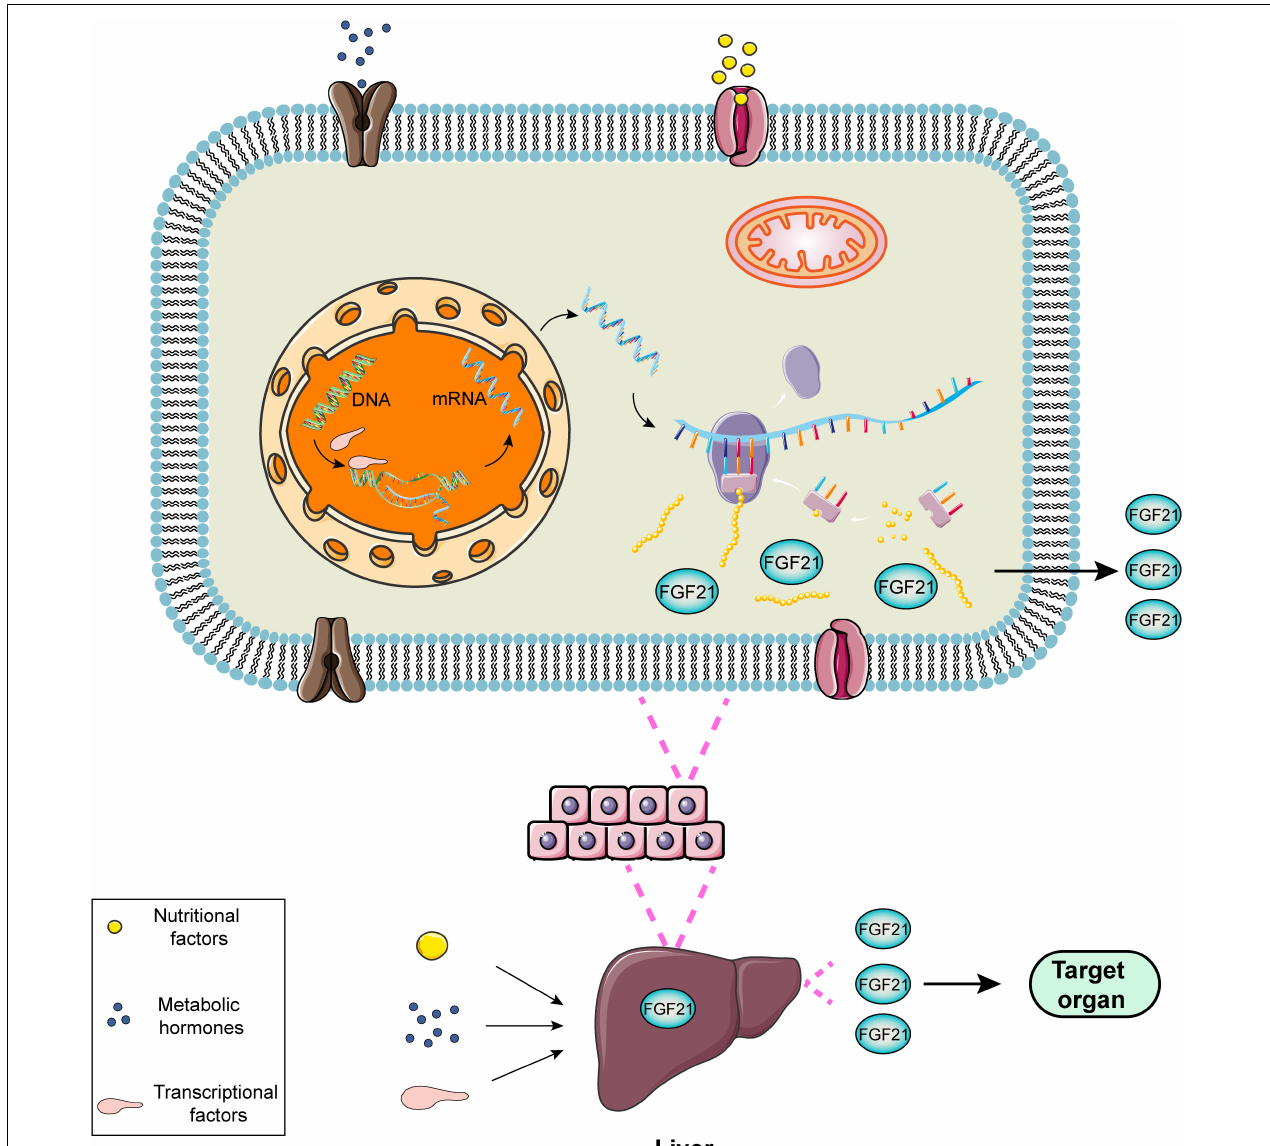
FIGURE 1 | Schematic diagram of the regulatory process of FGF21 expression. FGF21 is a liver-derived hormone regulated by some elements such as nutritional factors, metabolic hormones or transcriptional factors. These factors contribute to improving the transcription and translation process and promoting FGF21 production via activating corresponding signaling pathways. FGF21 secreted from the liver performs potential biological roles in the target